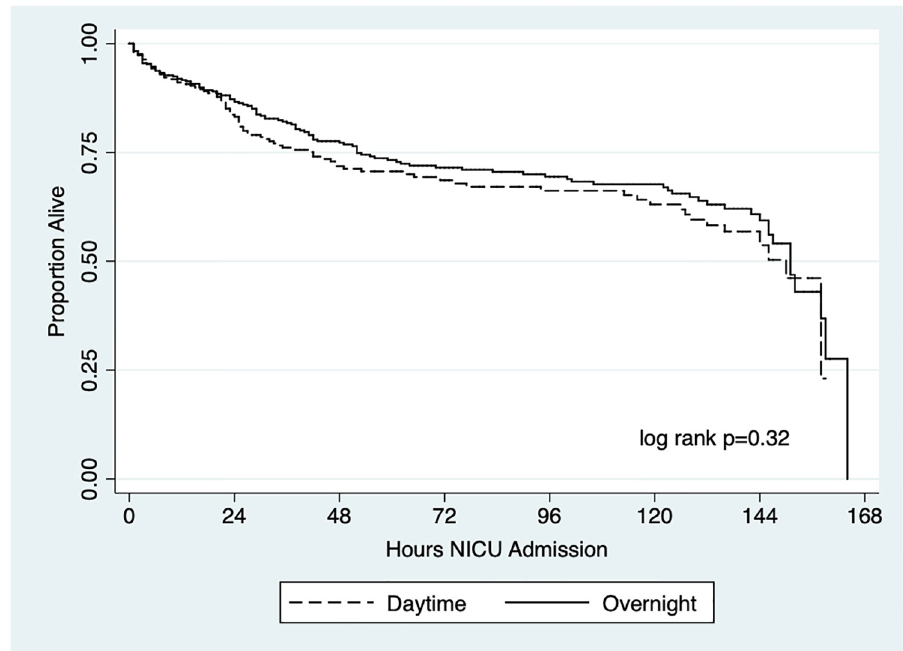
Fig 1. Kaplan-Meier survival curve comparing daytime and overnight NICU